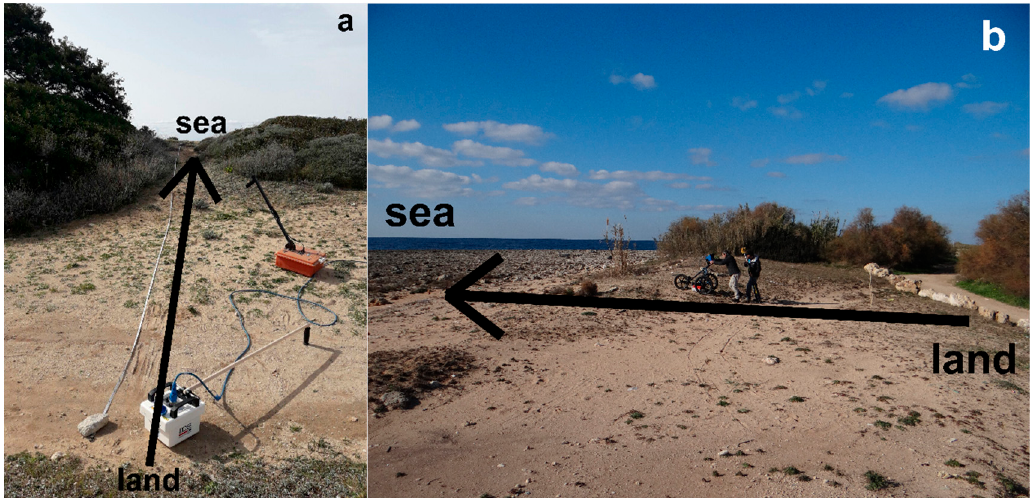
Figure 9. a, b —Location of GPR surveys carried out at Profile S1 (La Strea site) (left) and at Profile S5 Figure 9. ( a , b )—Location of GPR surveys carried out at Profile S1 (La Strea site) ( left ) and at Profile S5 (L’Arenile site) (right). See Figure 5 for the location. (L’Arenile site) ( right ). See Figure 5 for the